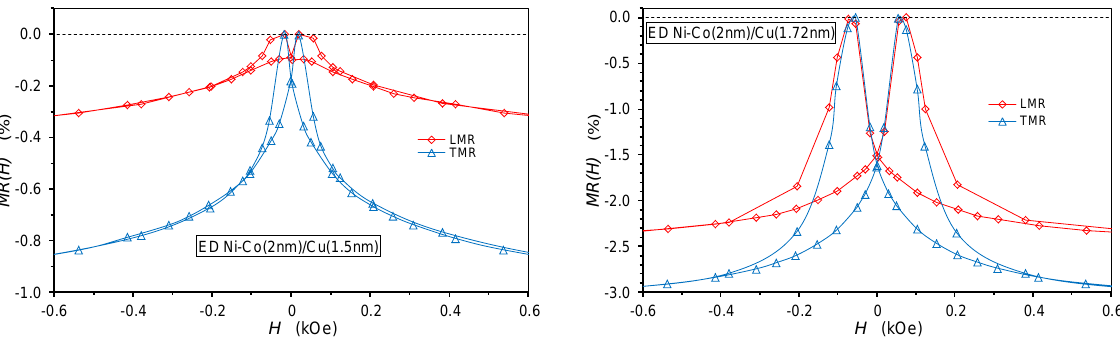
Figure 15. MR( H ) curves at large resolution for the present Ni65Co35/Cu multilayers with spacer layer thicknesses t Cu = 1.5 nm ( left panel ) and t Cu = 1.72 nm ( right panel ).